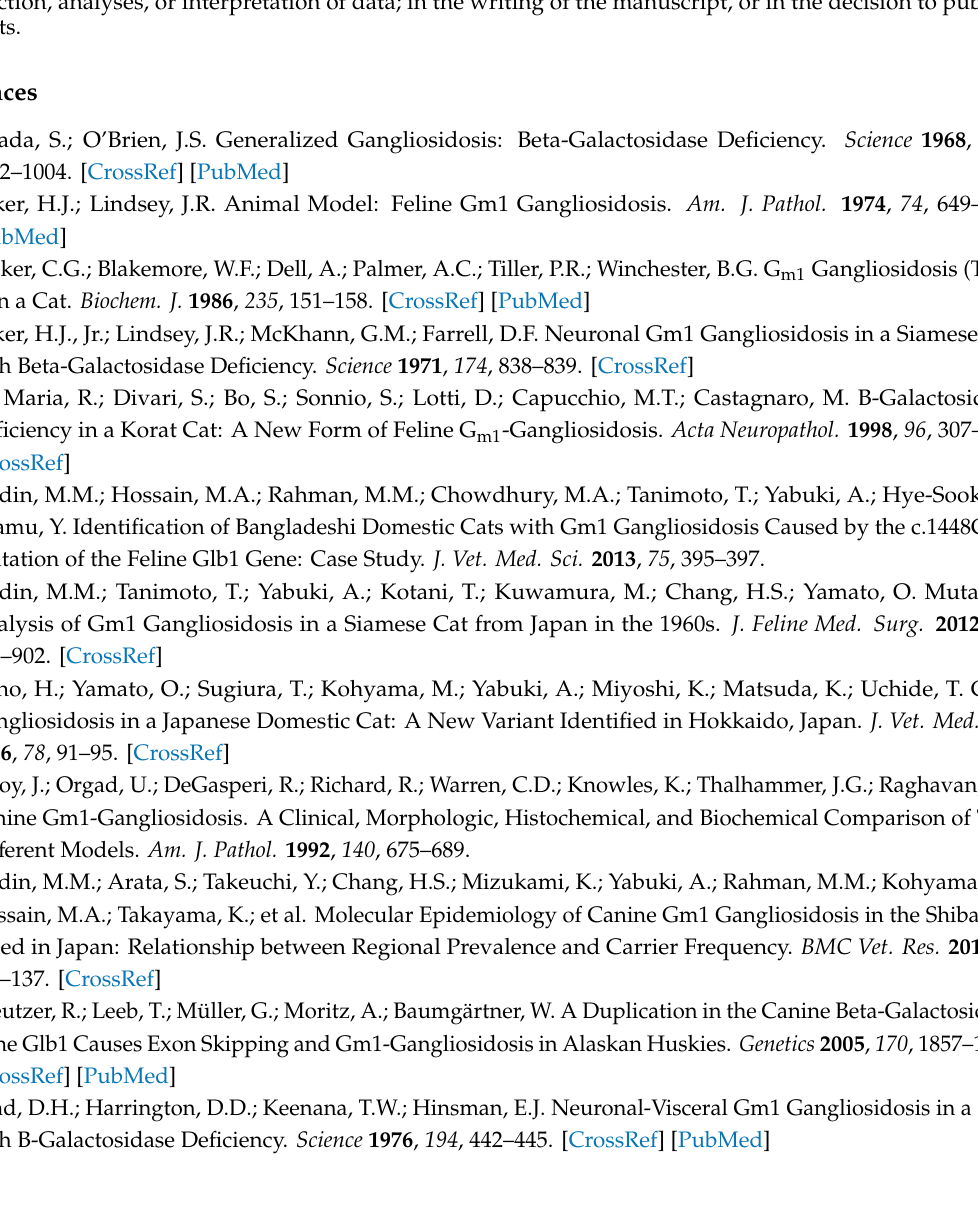
S8: Lack of storage material in glial cells. Figure S9: Glycolipid content of fibroblasts from four-month-old WT and Glb1 − / − mice. Figure S10: Glycolipid concentration of